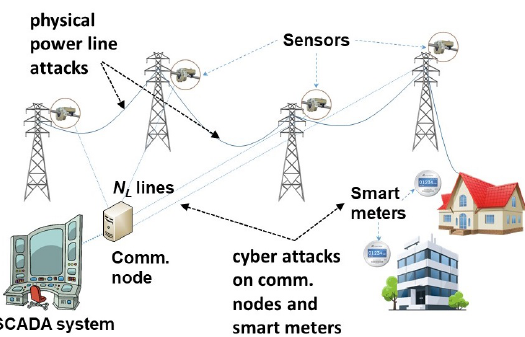
Figure 3. Smart power grid infrastructure. SCADA: supervisory control and data